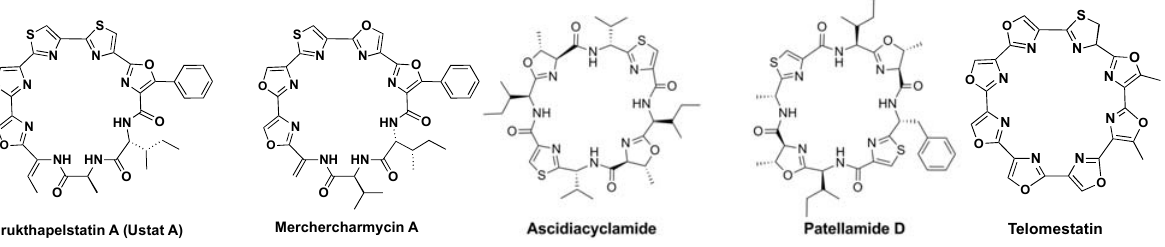
Figure 1. Ustat A and related structures: merchercharmycin A (IB-01211) [25–27], ascidiacyclamide [20], patellamide D, and telomestatin